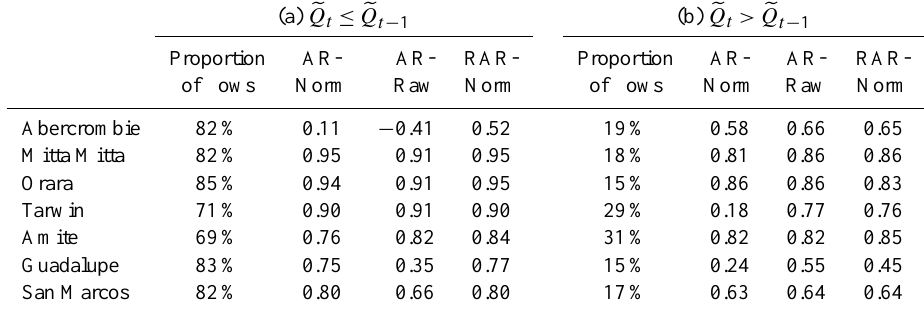
Table 2. Comparison of the NSE calculated at (a) the receding limb and (b) the rising limb of the hydrograph for three different error models.